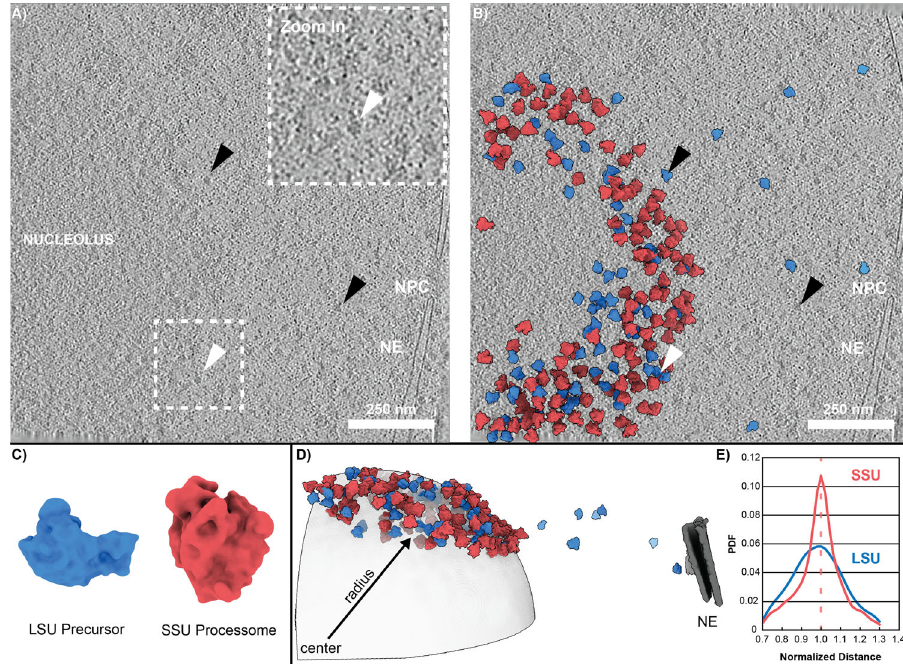
Fig. 1 Structural and molecular organization of the C. reinhardtii nucleolus. A The C. reinhardtii nucleolus is clearly visible as a dense structure decorated with large particles (white arrow & zoom in). Some of these particles (black arrows) are also found fl oating in the nucleoplasm. B , C Using reference-free template matching, pre-60S particles (blue) and SSU processomes (red) are detected ( n = 85 tomograms). D Their 3D organization is consistent with a sphere decorated by pre-ribosomes ( n = 26 tomograms for which spheres could be fi t). E The small subunit precursors show a characteristically different probability density function (PDF) than the pre-60S, with a sharper peak around the nucleolar surface ( n = 26 tomograms; Fisher-Pitman permutation test 60 with signi fi cantly smaller variance for the SSU: p = 1.0E – 06). LSU Large Subunit, SSU Small Subunit, NE Nuclear envelope, NPC Nuclear Pore Complex. Source data are provided as a Source Data fi le.